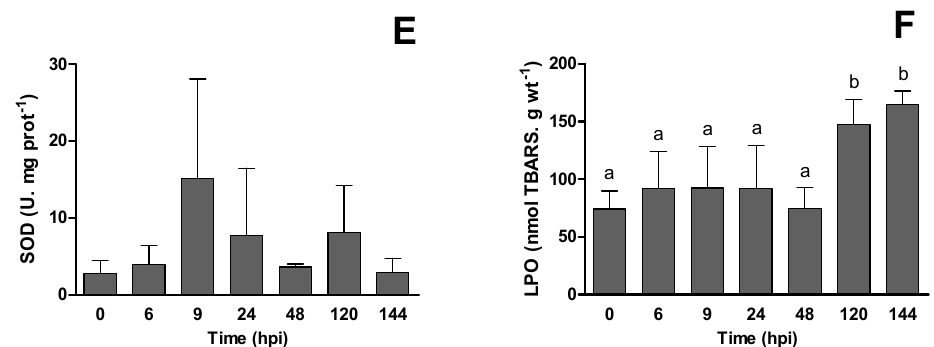
Figure 3. Antioxidant activity in the liver and albumin plasma concentration in European seabass ( Dicentrarchus labrax ) infected with RGNNV at different sampling times post-infection (hpi): ( A ) catalase activity (CAT), ( B ) albumin, ( C ) glutathione-s-transferase activity (GST), ( D ) total glutathione (tGSH), ( E ) superoxide dismutase (SOD) and ( F ) lipid peroxidation (LPO). Values are presented as mean ± SD ( n = 6). One-way ANOVA was used to compare between different sampling times. Different letters show statistically significant differences between sampling times ( p < 0.05).